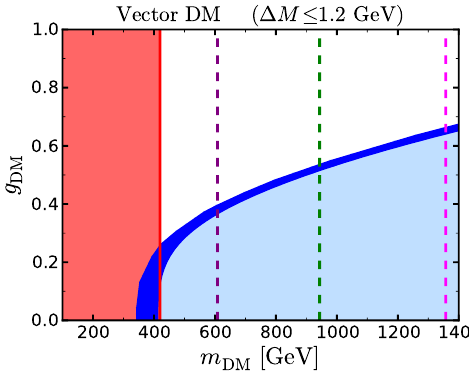
Figure 12 . Model 3: the co-annihilation strip and collider searches for vector DM and a long-lived charged Dirac fermion (cid:9). The dark-blue region satis(cid:12)es the correct dark matter relic abundance within 3 (cid:27) , the light-blue region overproduces the dark matter energy density. The horizontal black line corresponds to the mass of the (cid:28) lepton. The region coloured in red corresponds to current HSCP limits for center-of-mass energy of 8 TeV and 18.8 fb (cid:0) 1 . The three dashed lines (purple, green and magenta) correspond to our projections for center-of-mass energy of 13 TeV and 30, 300 and 3000 fb (cid:0) 1 of integrated luminosity respectively.